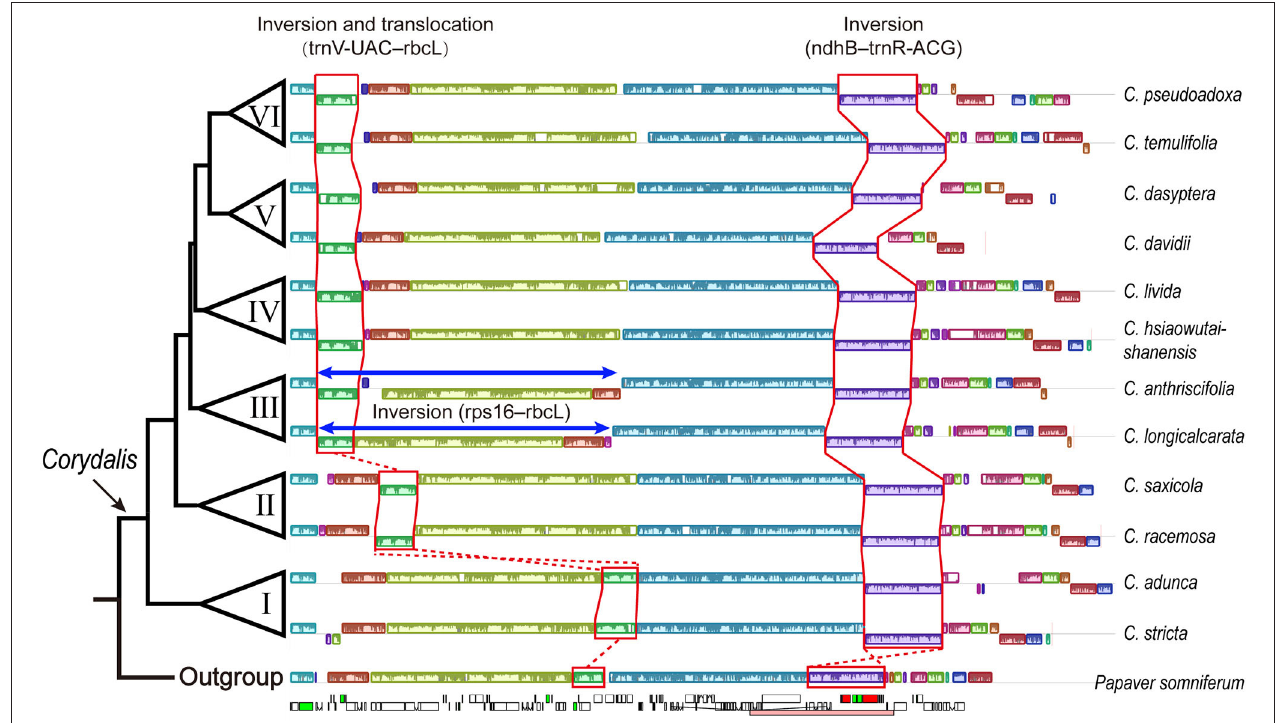
FIGURE 2 | Major structural rearrangements in Corydalis plastome. For each species, only one IR region was included. Colored blocks represent locally collinear blocks (LCBs). Blocks drawn below the horizontal line indicate sequences found in an inverted orientation. The relevant genes and the range of IR region (pink boxes) were indicated in the outgroup plastome.